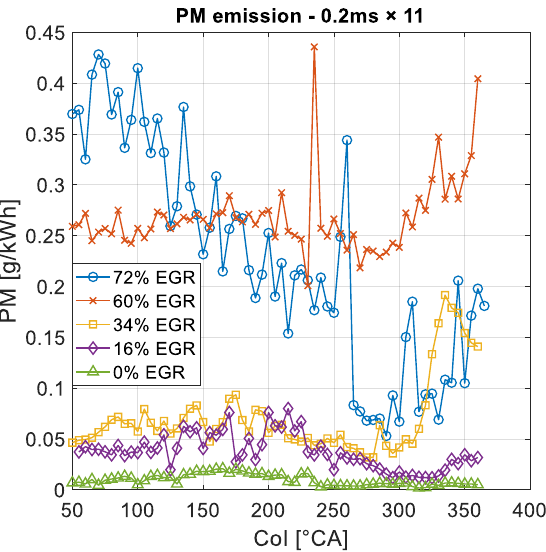
Figure 19. The NO x emission of the 0.2 ms × 11 structure with different EGR rates in the function of CoI.